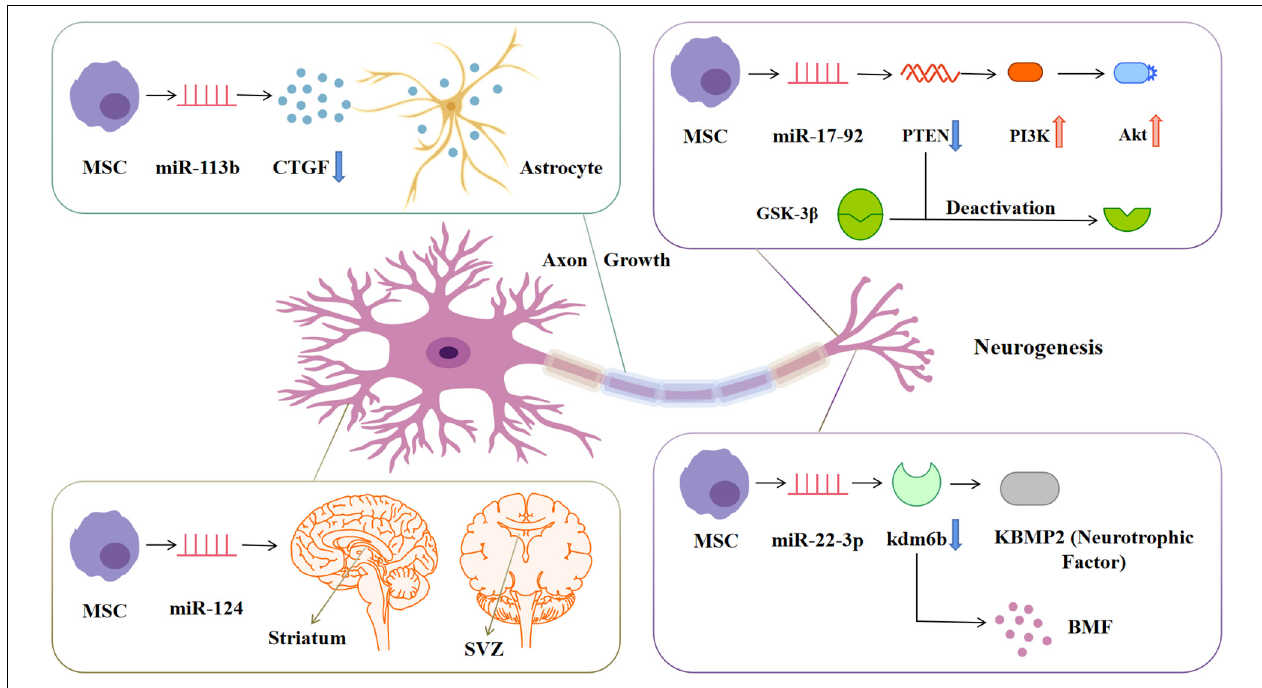
FIGURE 5 | MiRNAs in exosomes secreted by mesenchymal stem cells stimulate cell and structure growth. miRNA-133b can down-regulate the expression of CTGF in astrocytes, reduce the formation of glial scar and promote the remodeling of myelin sheath. miRNA-17-92 can down-regulate the expression of PTEN, thereby activating the PIK3-Akt pathway and inactivating GSK-3 β , promoting the growth of neuronal axons. miRNA-124 promotes neurogenesis in SVZ and striatum regions. miRNA-22-3p can inhibit KDM6B-mediated KBMP2/BMP pathway and play a neurotrophic role. CTGF, Connective tissue growth factor; PTEN, Phosphatase and tensin homolog; PIK3, Phosphatidylinositol 3-kinase; Akt, Protein kinase B; GSK-3 β , Glucogen synthase kinase-3 β ; SVZ, Subventricular zone; KDM6B, Lysine(K)-specific demethylase 6B; KBMP2, Neurotrophic factor; BMP, Bone morphogenetic